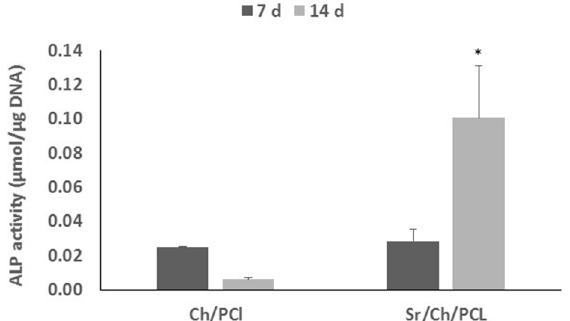
Figure 7. ALP/DNA activity in MG-63 cells cultured directly on test materials over a period of 14 days. Results are the mean ± sd ( n = 5). Asterisks (*) indicate a significant difference comparing the two groups at the same time (* p < 0.05). Ch: chitosan; PCL: poly( ε -caprolactone).